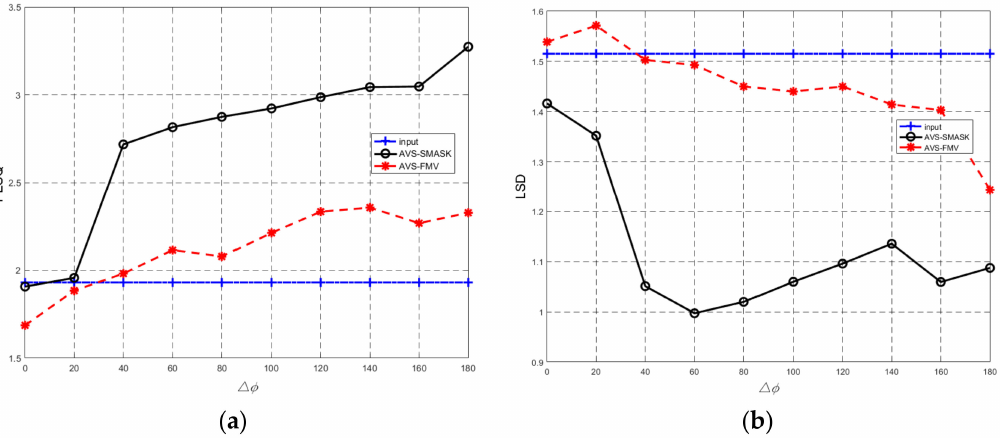
Figure 6. (Experiment 2) The perfomance versus ∆ φ . ( a ) Perceptual evaluation of speech quality (PESQ) results and ( b ) Log spectral division (LSD) results (Case 1: φ s of the target speaker changes from 0 ◦ to 180 ◦ ) (Case